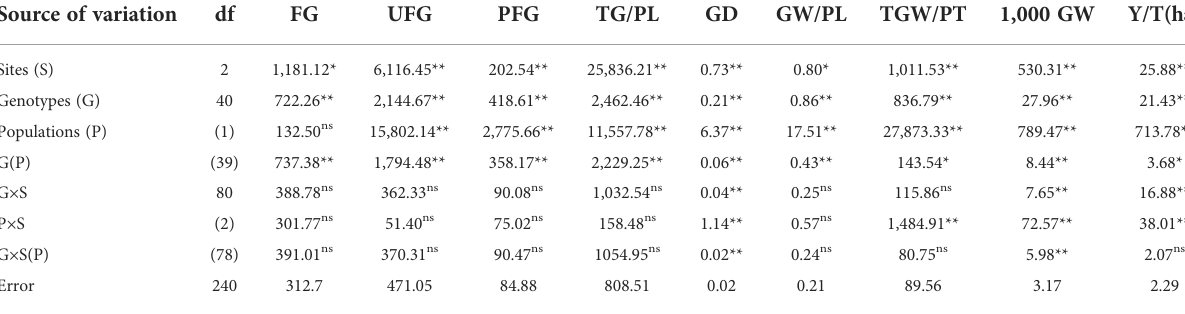
TABLE 6 Yield and yield components by combined site and